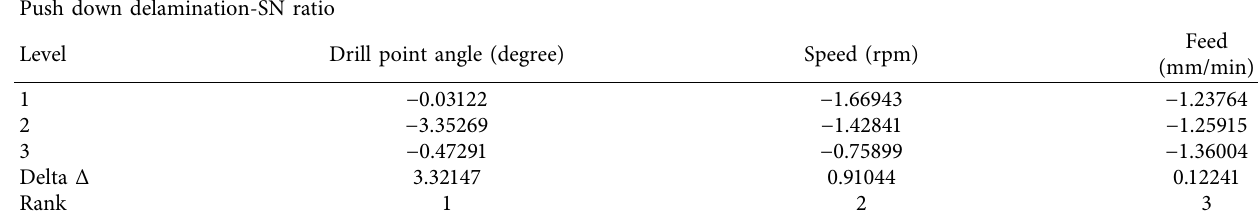
Table 5: Signal-to-noise ratios response table.